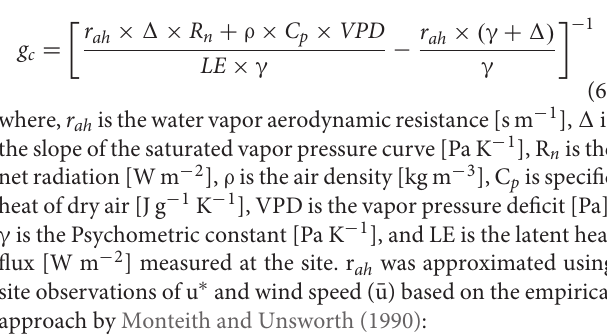
TABLE 2 | Variables used as drivers in the ANN models used to gap fill different fluxes.